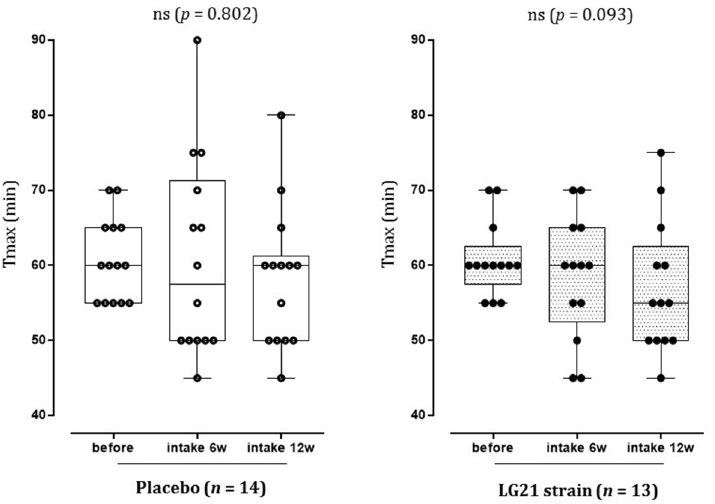
Figure 4. Tmax after 6 and 12 weeks of intake compared to before intake (per-protocol): Tmax after 6 weeks of intake and after 12 weeks of intake compared to before intake for the placebo group and the LG21 strain group are shown as dot plots and box plots (median, 25th to 75th percentile; bars show minimum and maximum). Intragroup comparisons were performed using the Friedman test (significance level, p < 0.05 [two-sided]). ns, not significant.